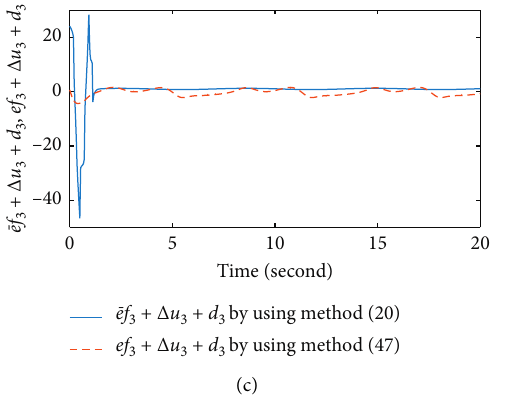
Figure 9: The trajectories of (a) e